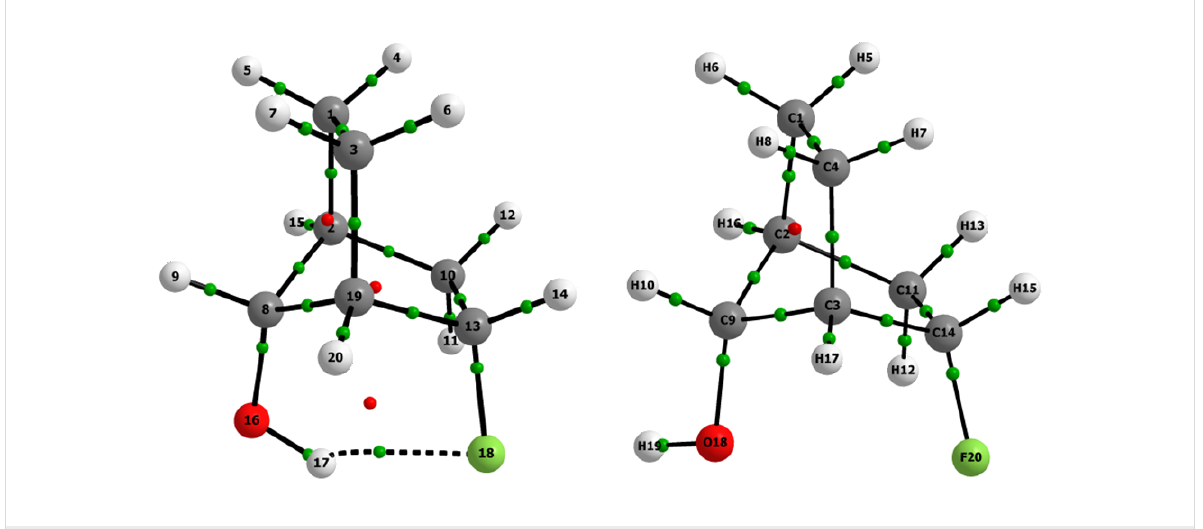
Figure 3: Molecular plots obtained by QTAIM for 5 . Green points represent bond critical points (BCPs) and red ones represent ring critical points (RCPs).